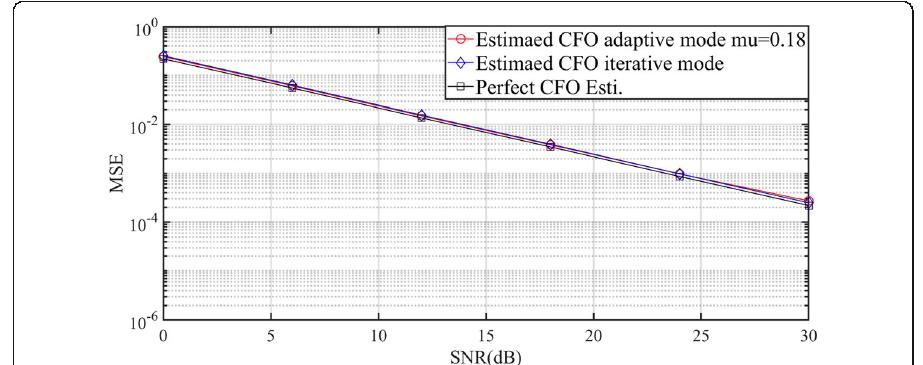
Fig. 14 The MSE performance for channel estimation in the adaptive mode at v = 500 km/h